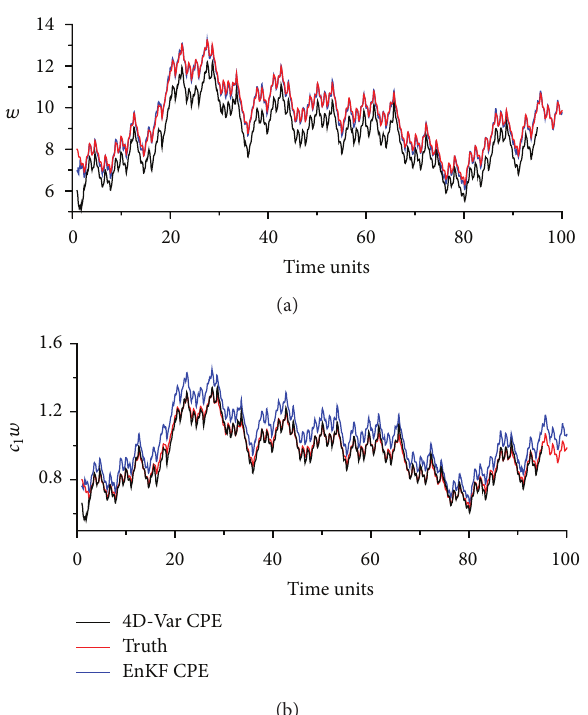
Figure 13: Time series of absolute errors of 𝑐 2 𝑥 2 for 4D-Var CPE (blue) and EnKF CPE (red) in EXP-4. In panel (a) (panel (b)), values of the observational interval, ensemble size, and MTW are 50 (5) time steps, 100 (10) time steps, and 1000 (50) time